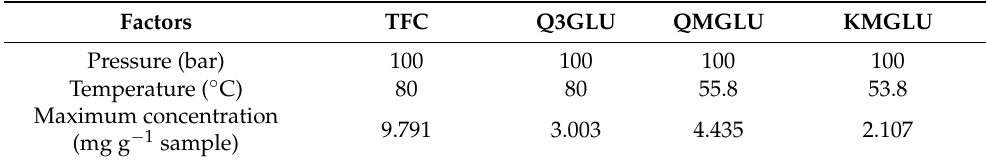
Table 4. Optimal values of the independent factors that maximize TFC, Q3GLU, QMGLU and K3GLU concentrations in the extracts.